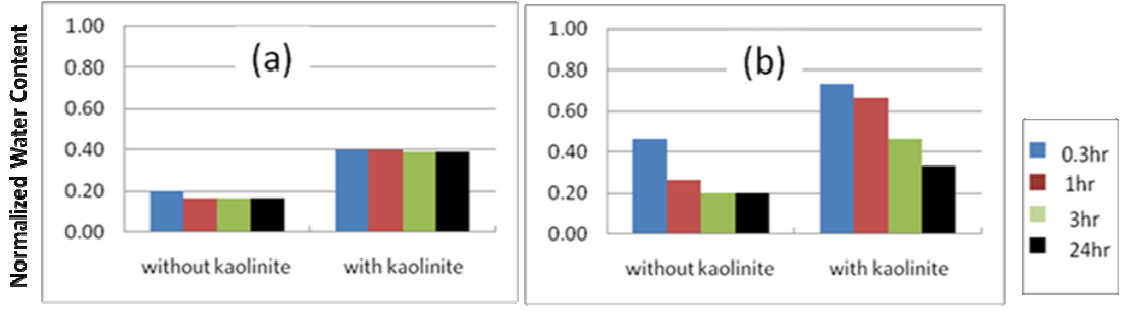
Figure 11. Comparison between emulsions with and without kaolinite at